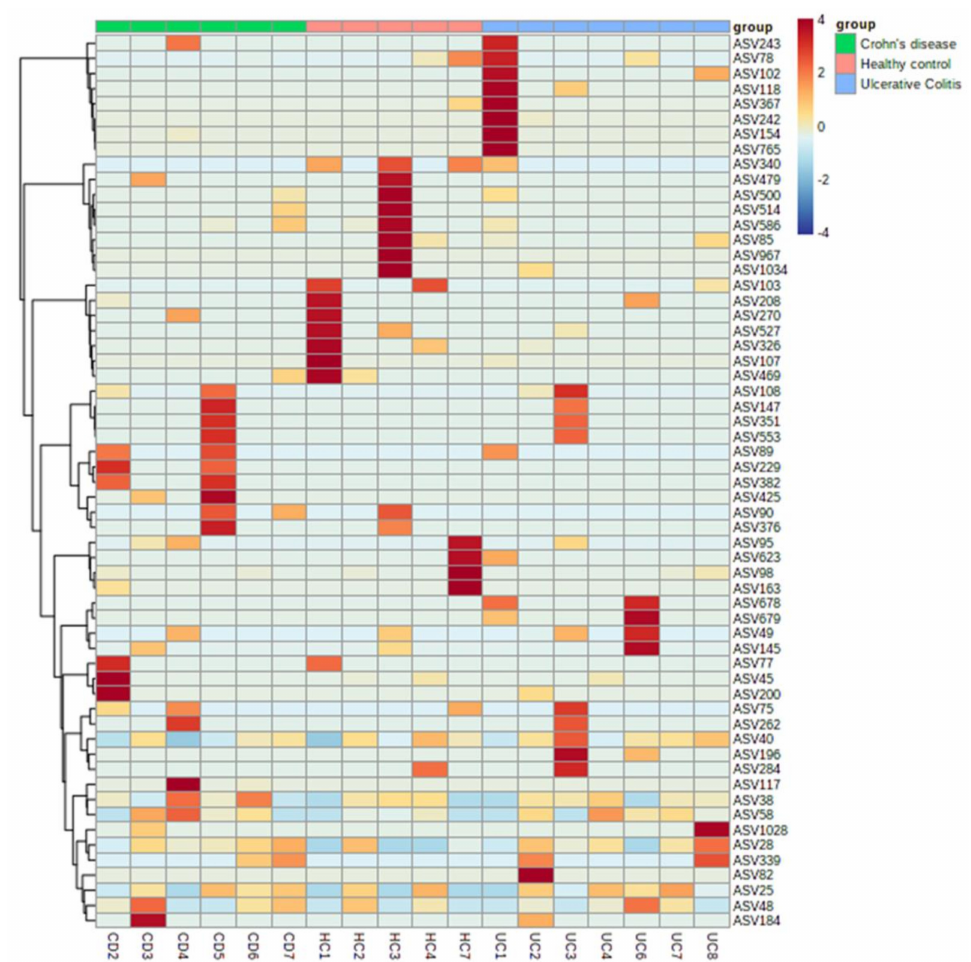
Figure 6. Hierarchical clustering and heatmap visualization at the feature (ASV) level. Heatmap clus- tering (Euclidean distance measure and Ward clustering algorithm) identified 59 ASVs observed in all groups (HC, Red; CD, green; and UC, blue). In HC, most observed taxa (dark red) were Proteobac- teria including Brevundimonas genus and Firmicutes including Bacillus, Enterococcus, Staphylococcus, and Streptococcus genus. In CD and UC, most taxa were Proteobacteria including Escherichia/Shigella , Paracoccus , Xanthobacter , Pseudomonas, and Lysobacter genus as well as Actinobacteria including Brachy- bacterium and Brevibacterium genus, and Firmicutes including Staphylococcus , Streptococcus, Lactococcus, and Lactobacillus